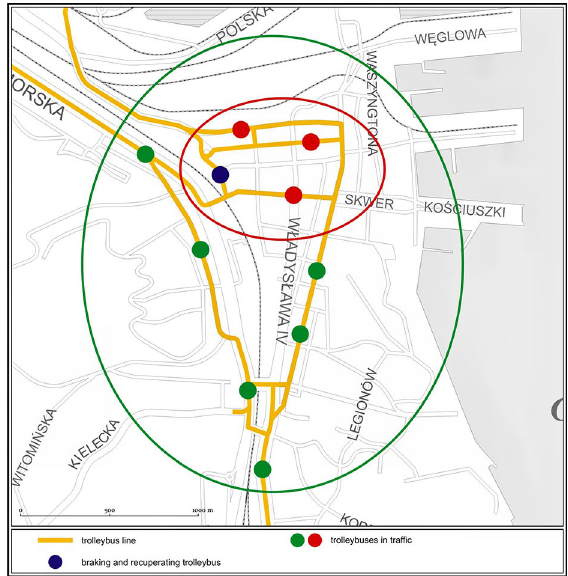
Fig. 8. An illustration of the effect of the size of the power supply area of the substation on electricity transmission losses – any increase in the size of the power supply increases the number of potential vehicles able to absorb the recouped